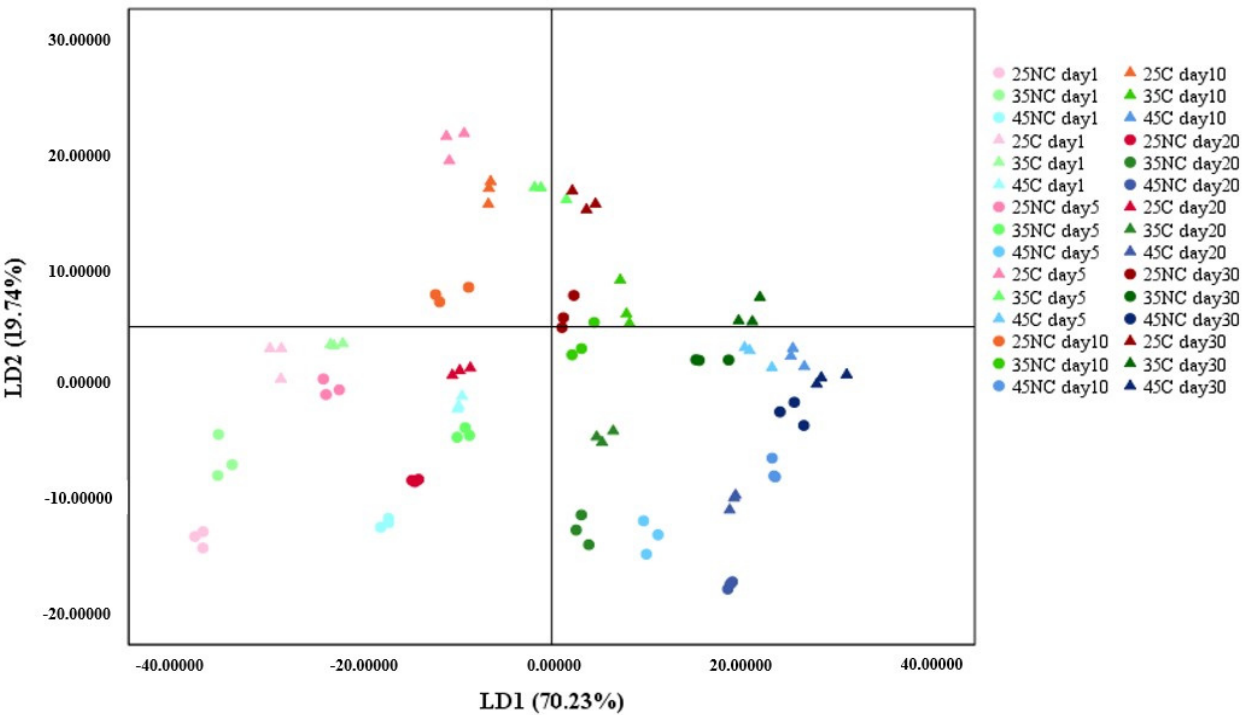
Figure 4. LDA analysis of boiled-dried anchovy over storage period.